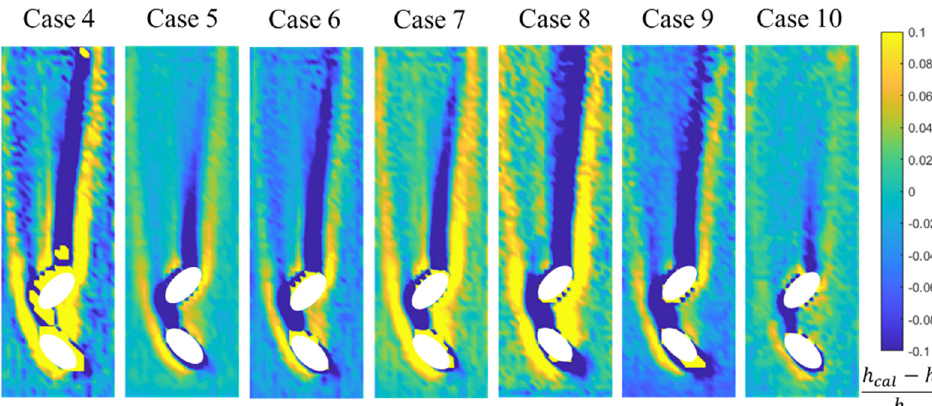
Figure 9. Errors of calculated heat transfer coefficient at M = 1.0.